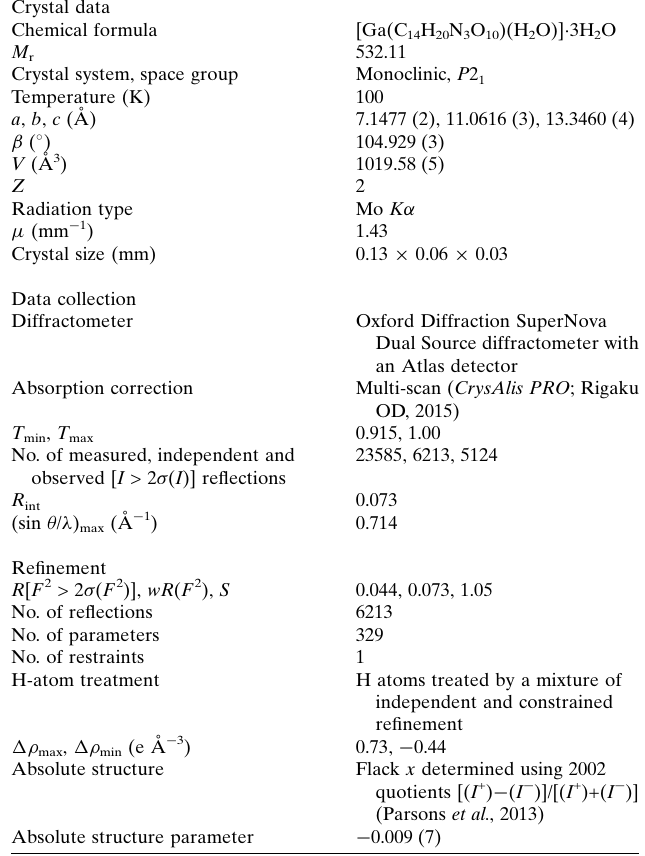
Table 2 Experimental details. Crystal data Chemical formula